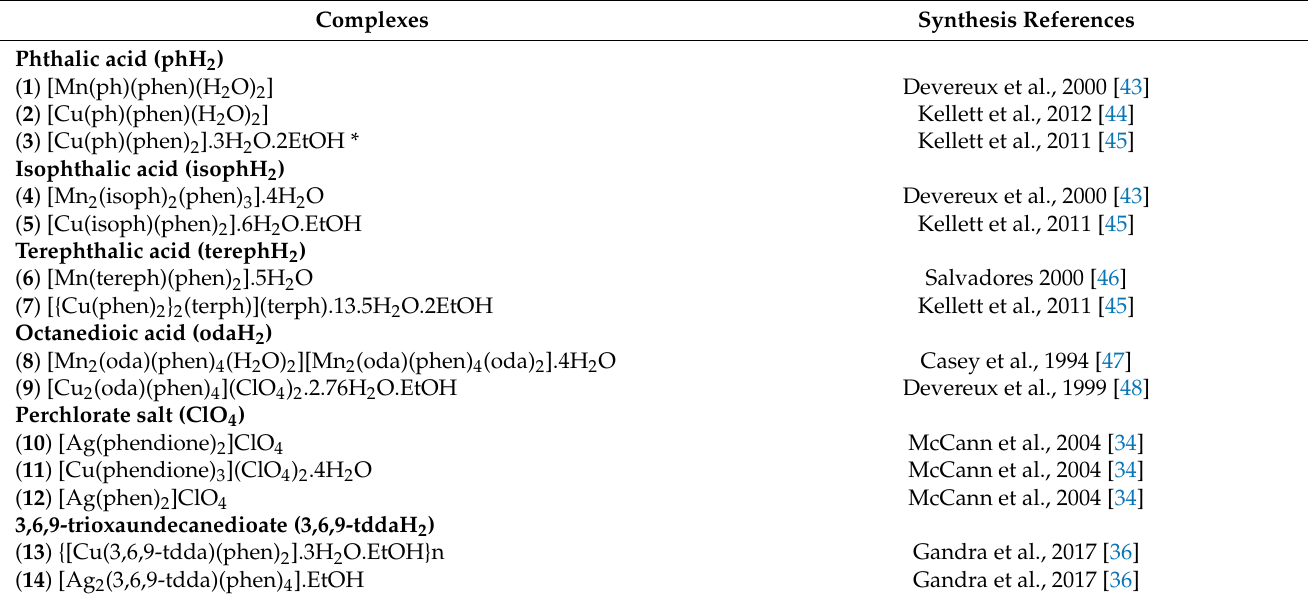
Table 1. Metal-based complexes tested in the present